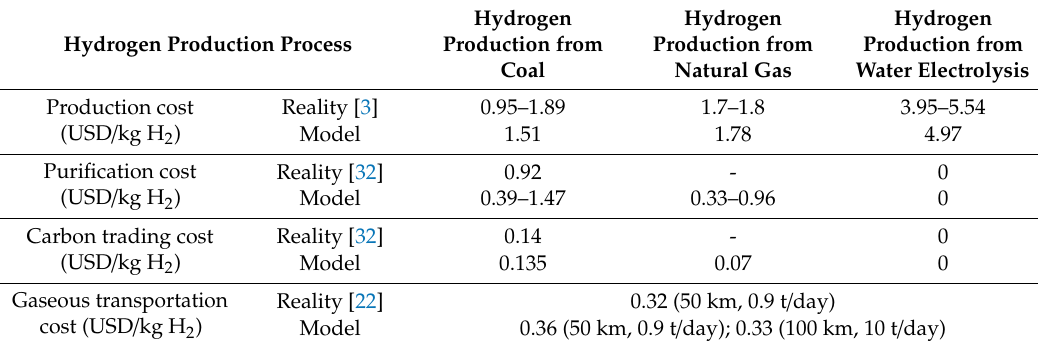
Table 9. Cost of reality and model